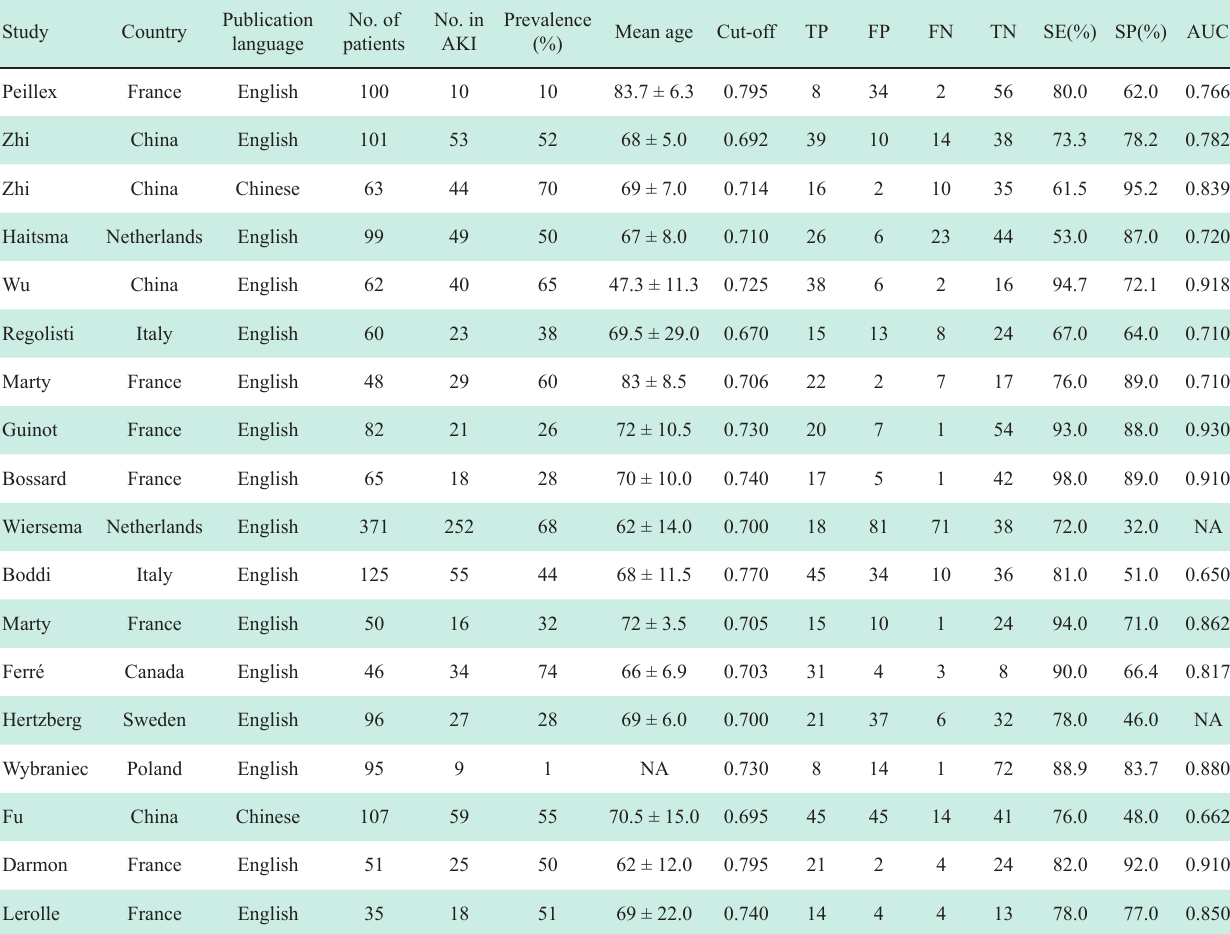
Table 1 Characteristics of the included studies and diagnostic test performance of RRI for acute kidney